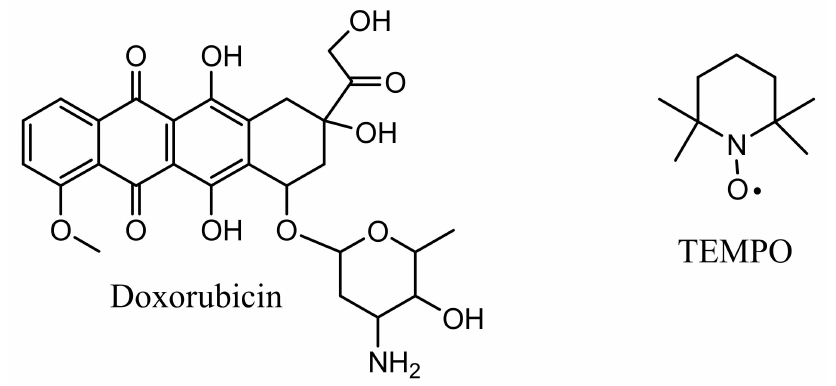
Figure 1. Chemical structure of doxorubicin and the TEMPO stable free